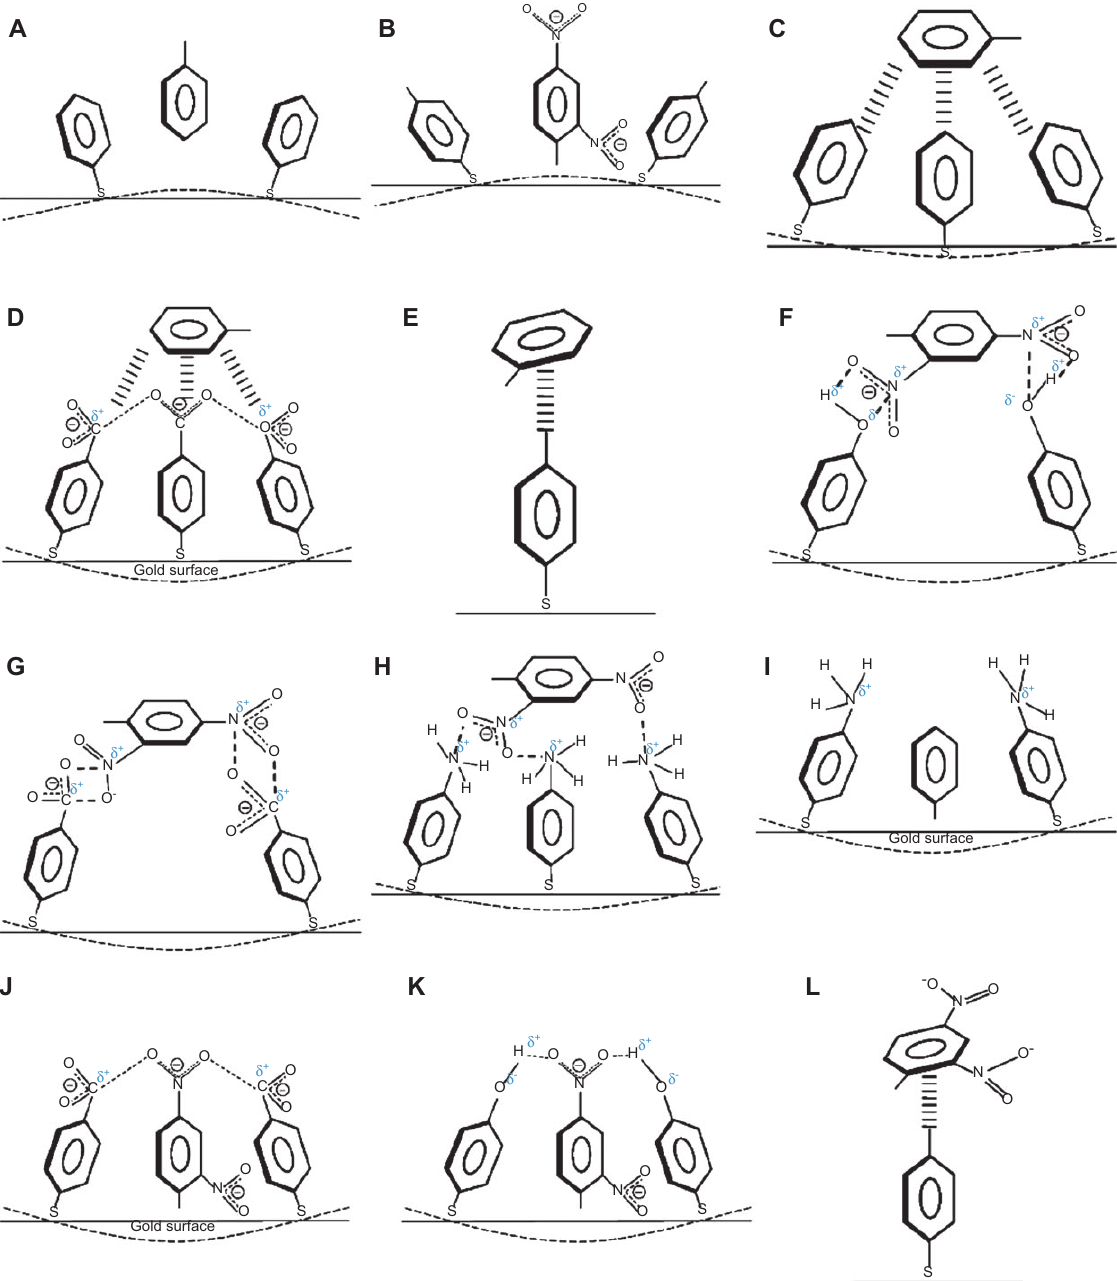
Figure 1 Representative conceptual diagram of possible molecular interactions between aromatic vapors and benzene thiols as receptors. Reproduced with permission from Raorane et al. (2008)